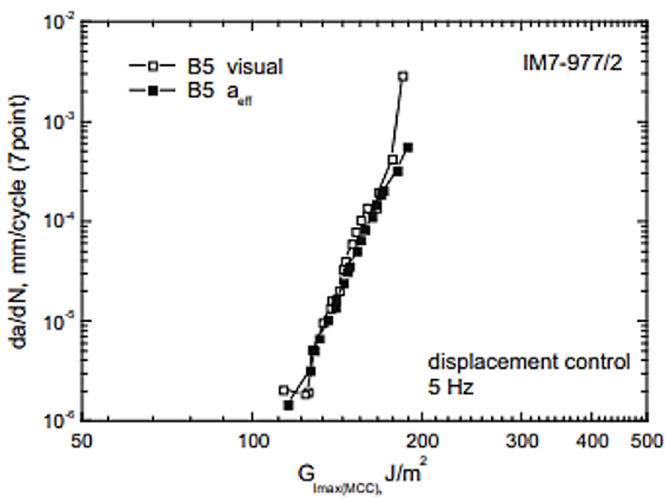
Figure 20. Comparison of visual versus effective delamination length measurement [14].